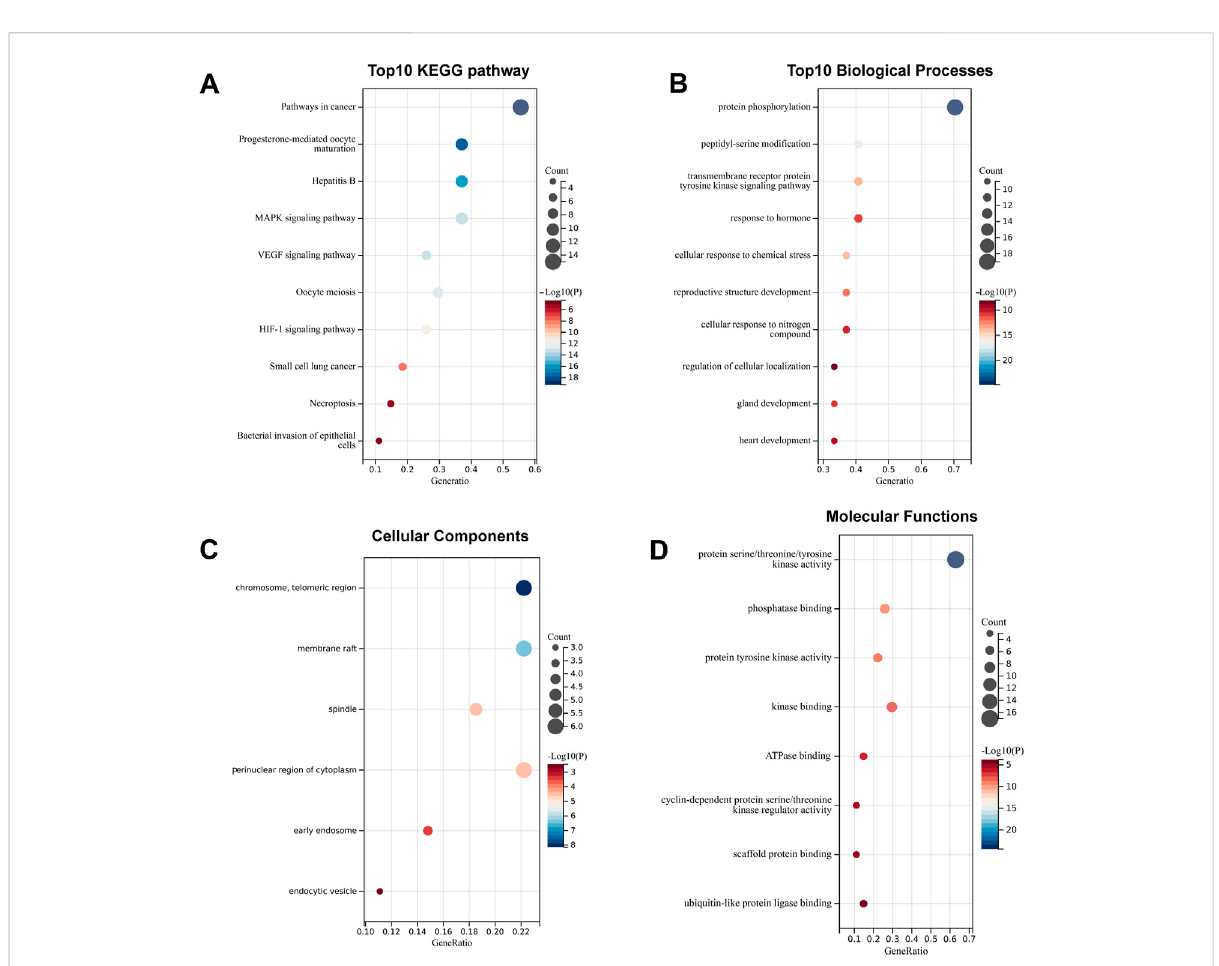
FIGURE 6 Functional analysis of SchB targets on adenovirus_hepatitis. (A) The top 10 enriched KEGG pathways of genes that SchB targets on adenovirus_hepatitis. (B – D) The top 10 enriched terms of biological process, cellular component, and molecular